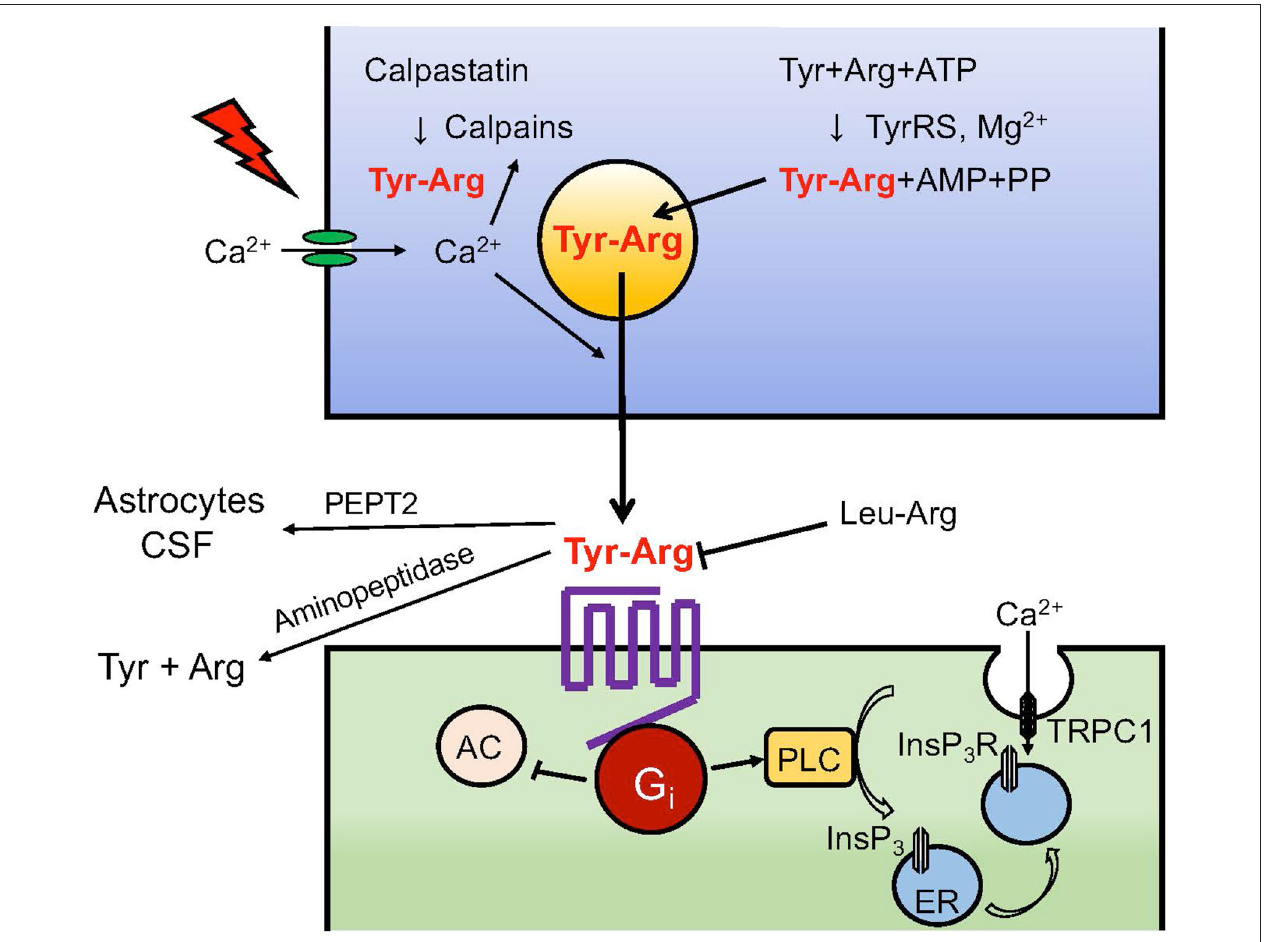
FIGURE 2 | Neurotransmission of kyotorphin. Details of TyrRS-mediated kyotorphin (Tyr-Arg) biosynthesis, depolarization-induced Ca 2 + -dependent kyotorphin release, kyotorphin receptor-G i coupling, PLC-InsP 3 R signaling, and inactivation system through degradation and excretion are described in the text. Kyotorphin receptor-mediated InsP 3 R activation may lead to a conformational coupling to TRPC1-dependent plasma membrane channels (